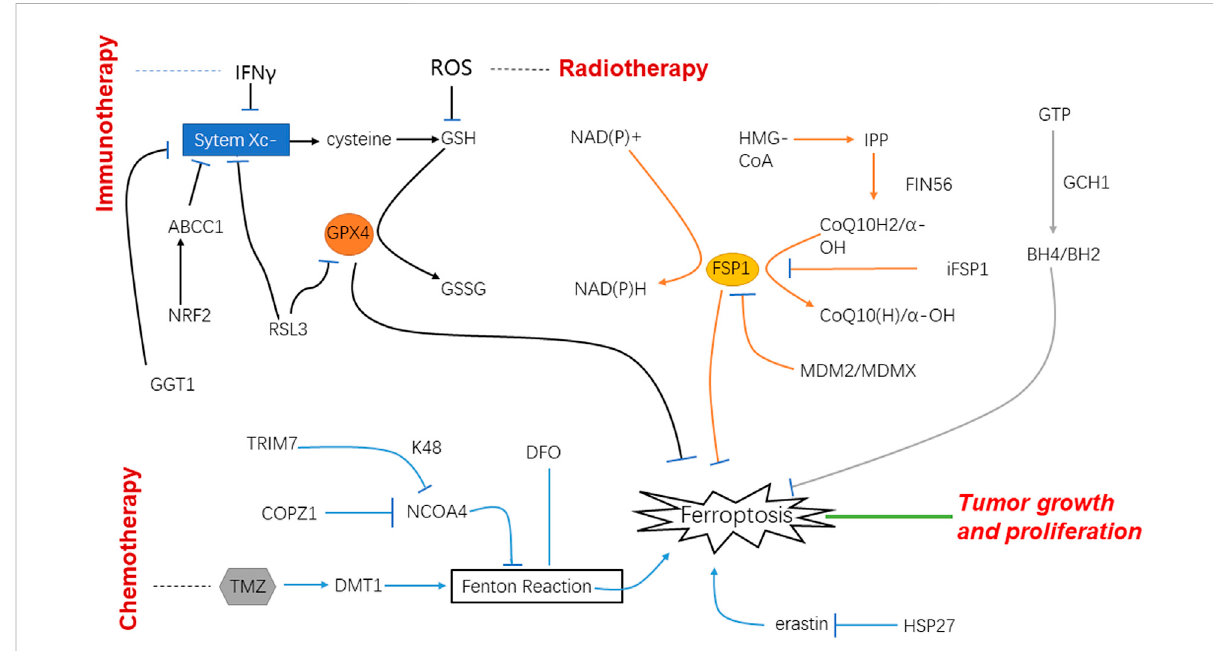
FIGURE 2 Schematic of mechanisms of ferroptosis and glioblastoma under the treatment of immunotherapy, radiotherapy and